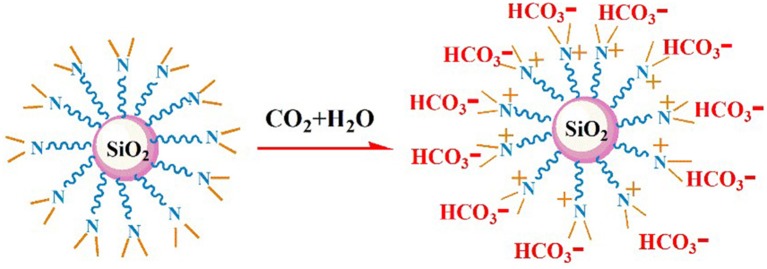
The process for NS–NR2 reacting with CO2.